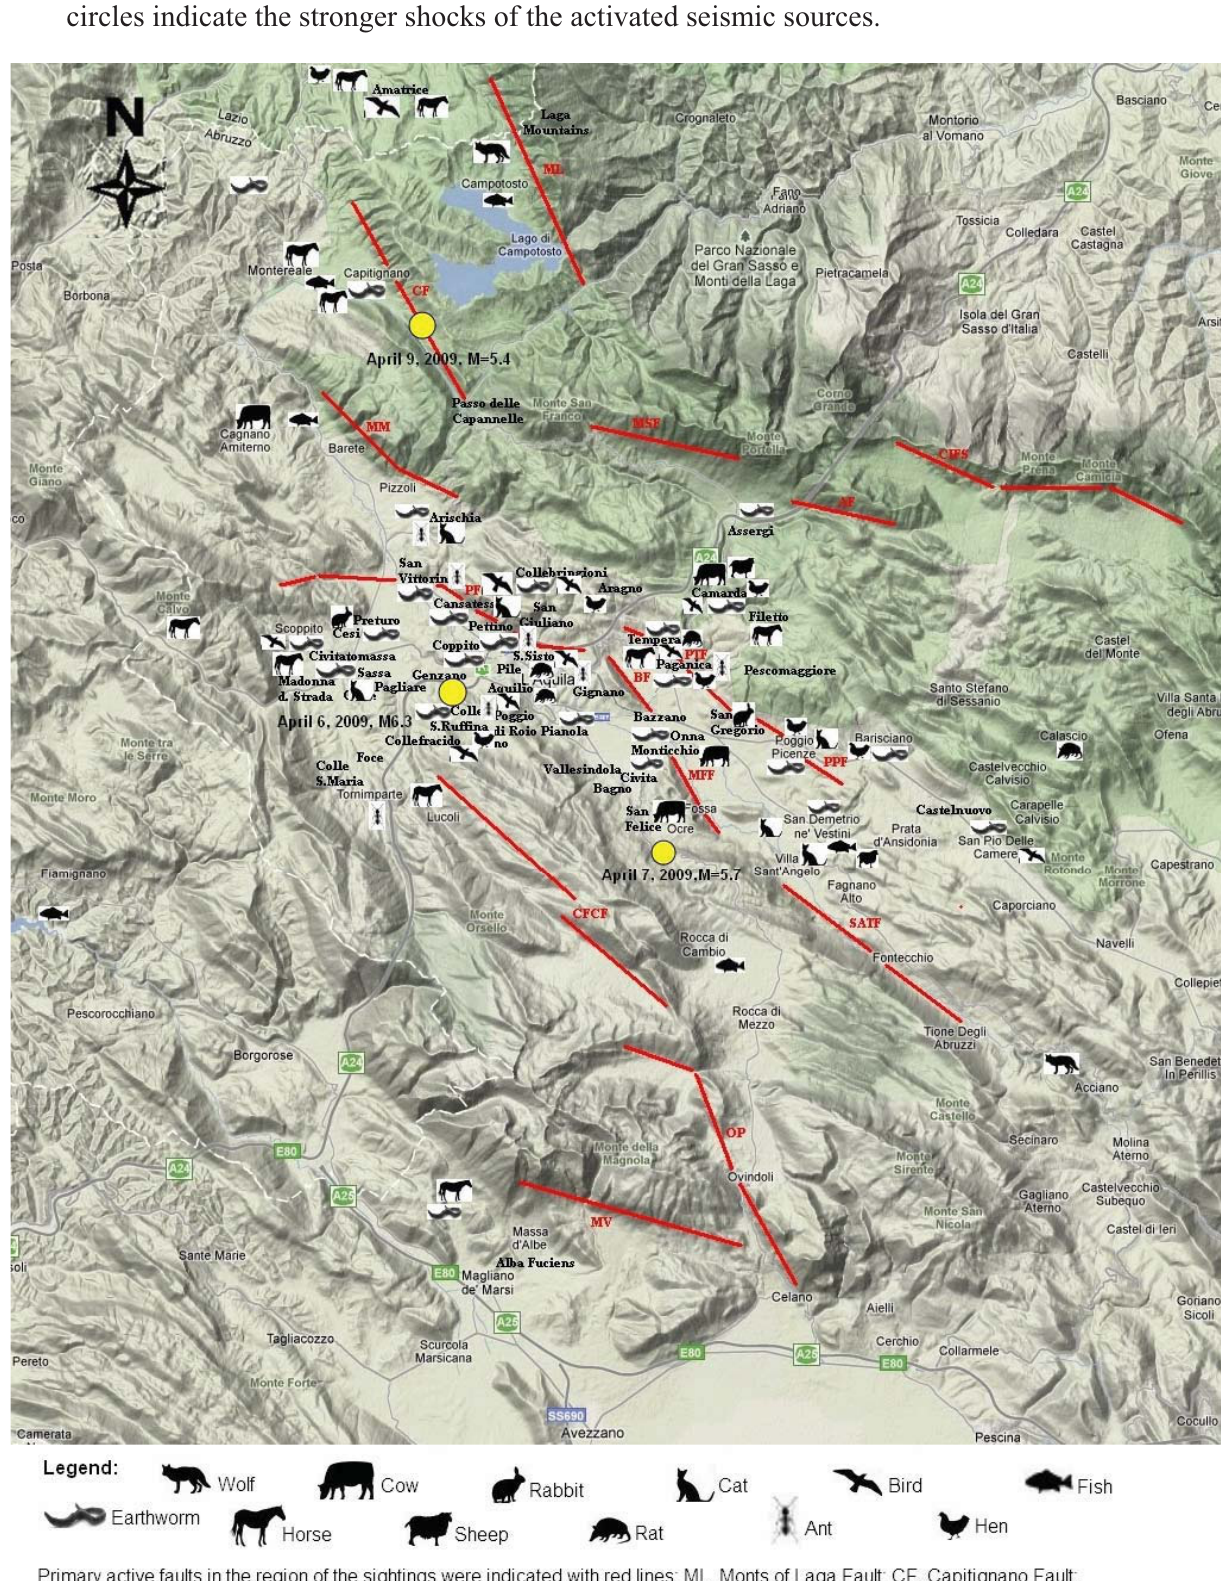
Figure 6. The geographical distribution of strange animal behavior with the legend; yellow circles indicate the stronger shocks of the activated seismic